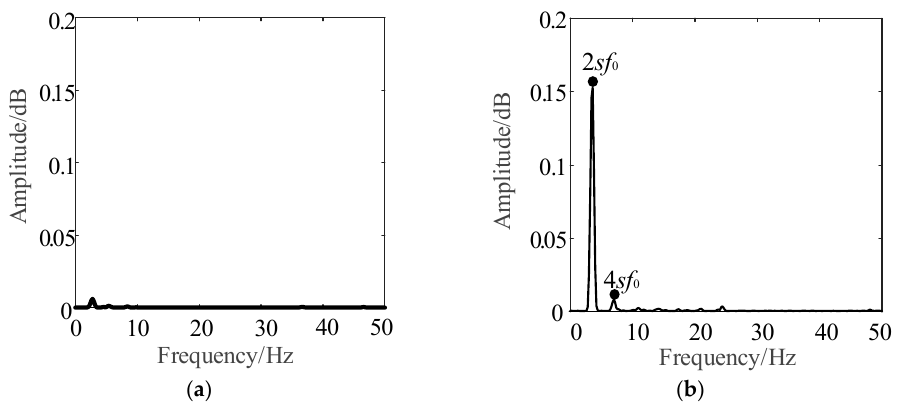
Figure 2. The fusion correlation spectrums of current signal and radial electromagnetic force signal. ( a ) Normal motor; ( b ) faulty motor with broken rotor bars.